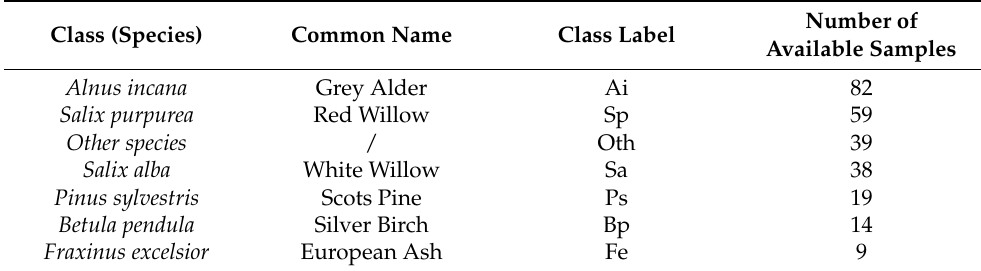
Table 6. Classes of the classification and number of available